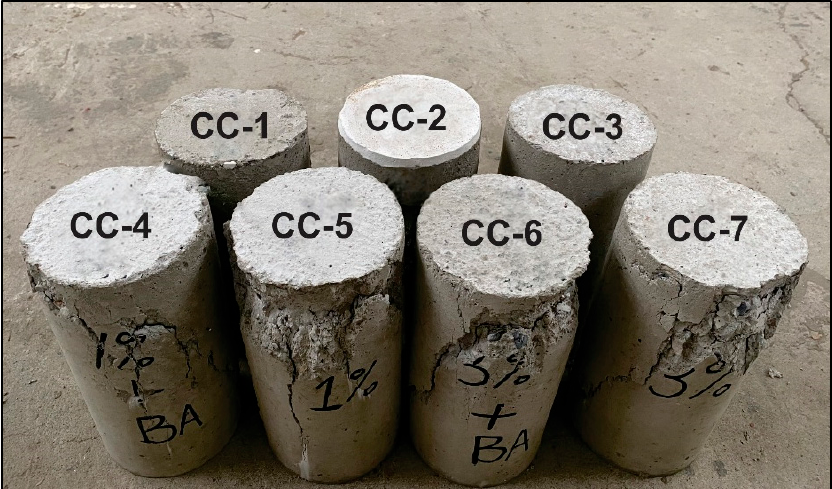
Figure 7. Photograph of cylindrical concrete specimens after applied load.